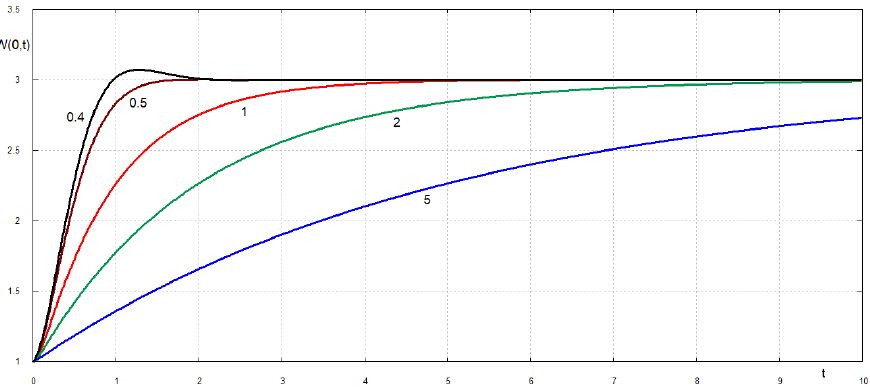
Figure 2. Displacements of the plate edge W ( 0, t ) after the plate breaking at t = 0 as functions of the dimensionless time for the dimensionless retardation times ˜ τ =